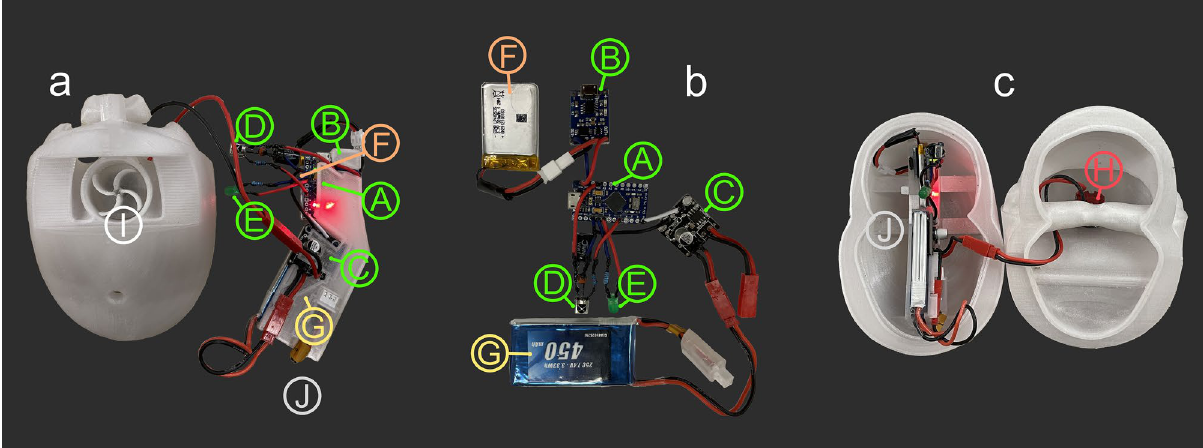
Figure 10. Biomimetic cephalopod robot components. ( a ) Ventral view of the sphaerocone biomimetic robot (before covering the pump and mantle cavities) with assembled electronics cartridge to the right. ( b ) View of electronic components that fit into the cartridge. ( c ) Electronics cartridge placed in robot. These two halves are fit together with wax to create a water-tight seal. Each model component is denoted by letters in circles: A = Arduino microcontroller, B = microcontroller charger / voltage regulator, C = motor driver, D = infrared sensor, E = indicator LED, F = microcontroller battery (3.7 V), G = motor battery (7.4 V), H = brushed motor, I = impeller and water pump cavity, J = electronics cartridge. The colors of annotations correspond to components depicted in Figs. 1 and